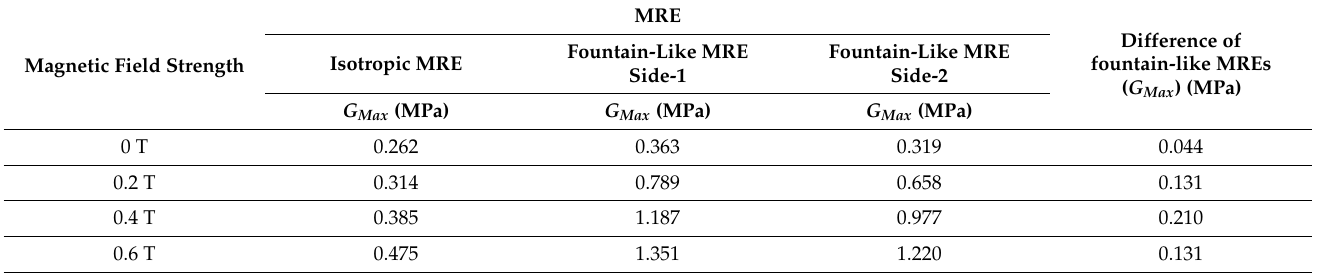
Table 4. Maximum storage modulus for all MRE samples and the difference in storage modulus for both sides of fountain-like MREs, in the frequency sweep